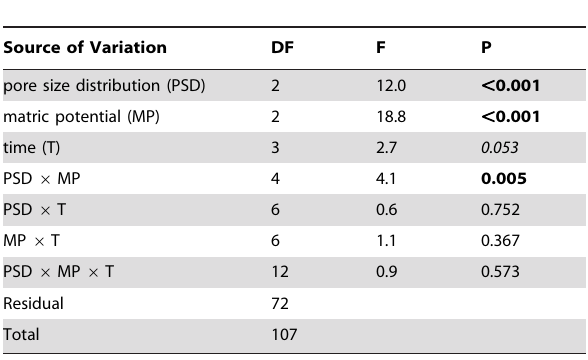
Table 2. Three-way ANOVA of factors affecting Bacillus/ Streptomyces (B/S)